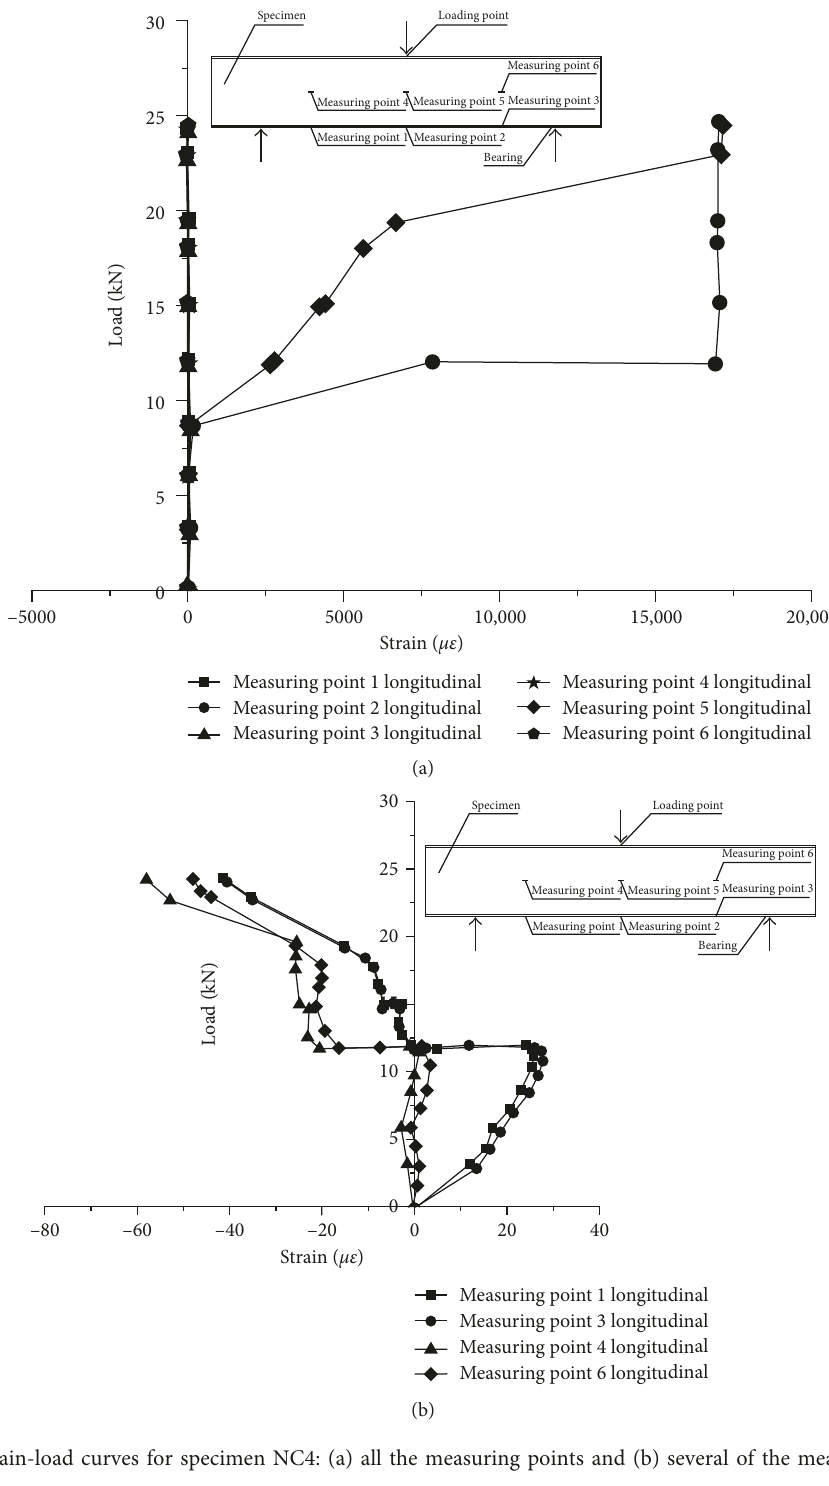
F IGURE 8: Strain-load curves for specimen NC4: (a) all the measuring points and (b) several of the measuring